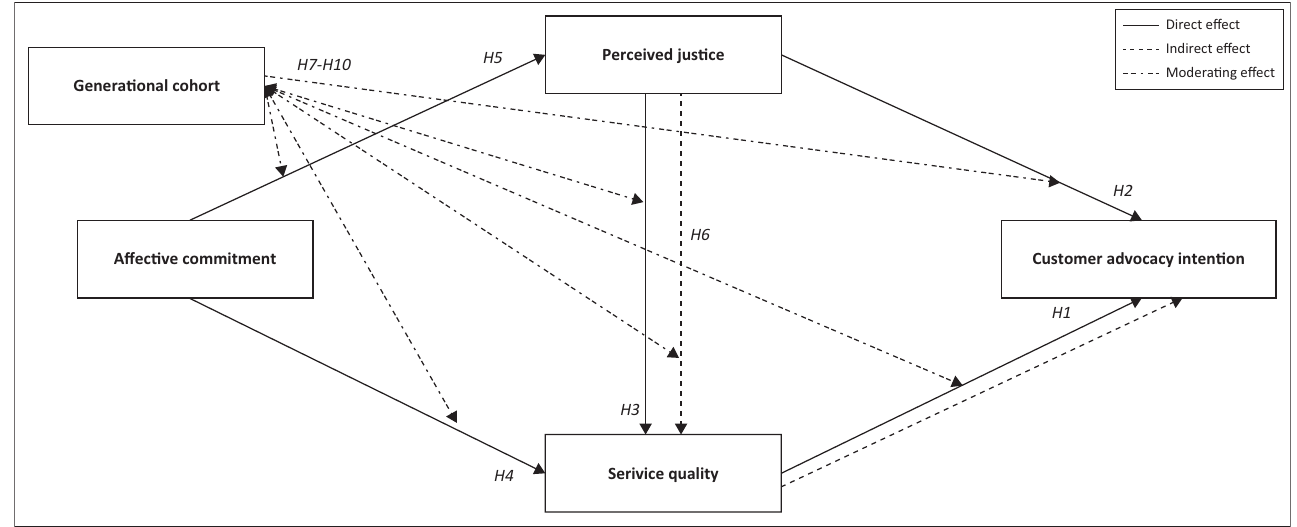
FIGURE 1: Conceptual model.